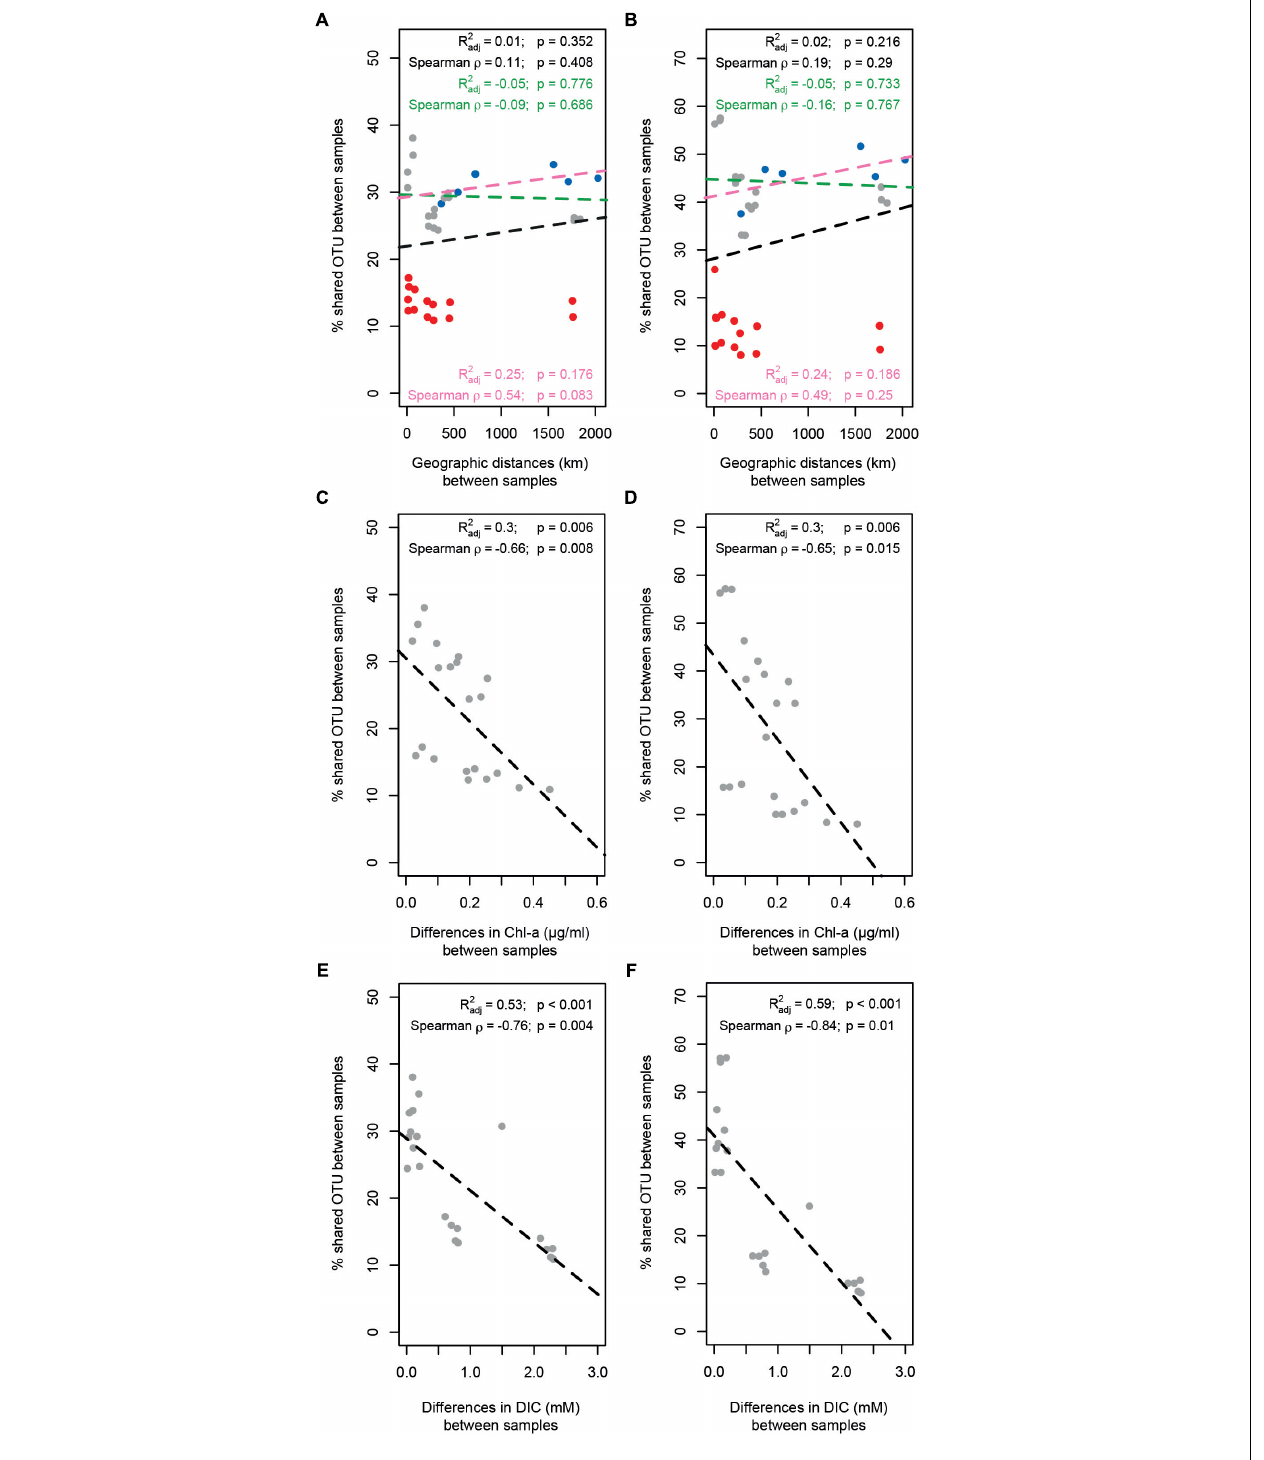
FIGURE 6 | Relationship between geographic distance, environmental patterns and similarity in surface microbial community composition. The proportion of (A) bacterial and (B) archaeal shared OTUs between samples did not show any significant relationship with geographic distance; three different scenarios have been evaluated: full data-set including all stations (all dots; black text and dotted line); excluding stations in Area 3 (red dots; green text and dotted line); considering only the stations outside SWIR (blue dots; pink text and line). The proportion of (C–E) bacterial and (D–F) archaeal shared OTUs between samples decreased significantly with differences in chlorophyll a content (Chl-a; C,D ) and dissolved inorganic carbon concentration (DIC; E,F ). Dotted lines are linear model fits. Linear models’ R 2 , Spearman’s rho correlations, and their significance (Mantel tests with 1000 permutations) are reported in each panel.